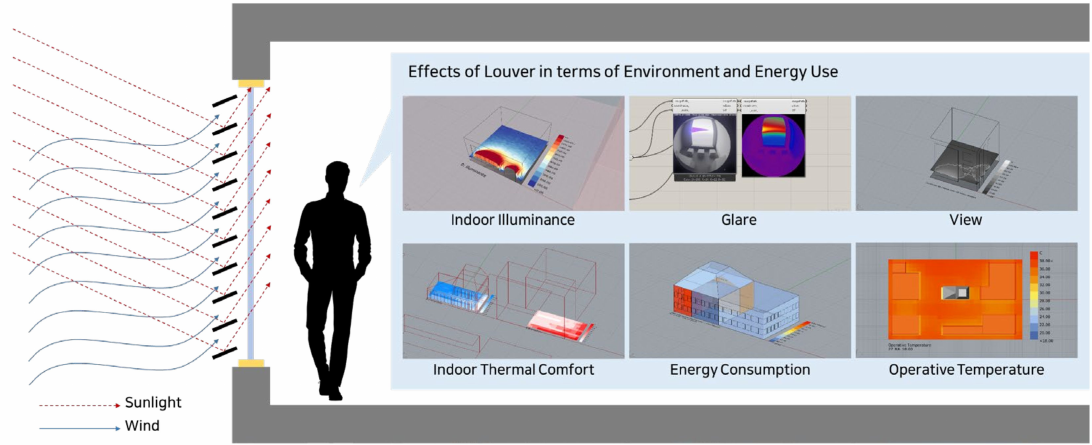
Figure 2. Environmental effectiveness of